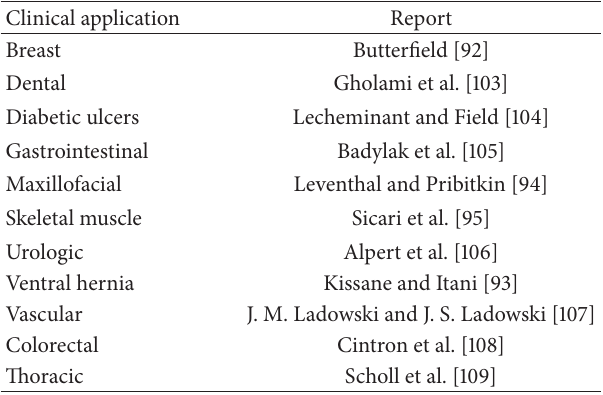
Table 3: Reports on clinical use of ECM-derived